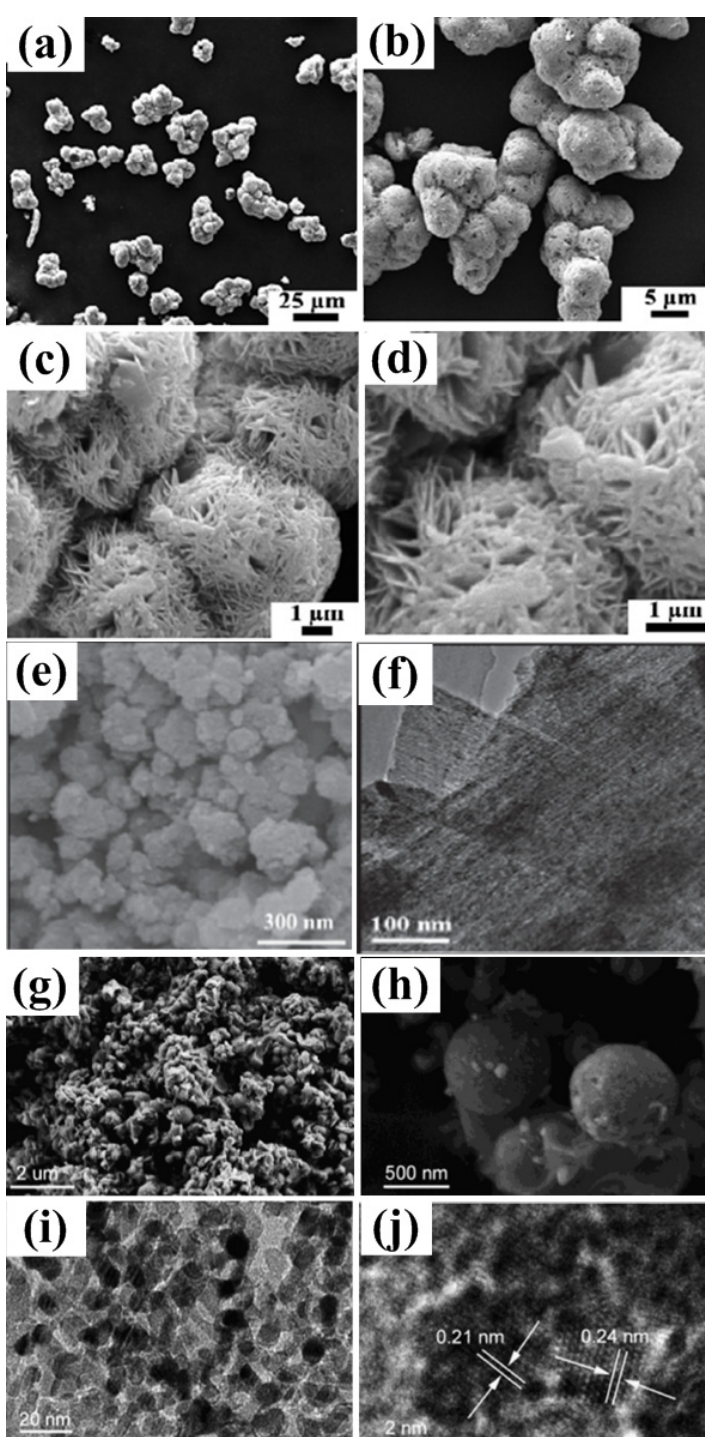
Figure 5. SEM images of the synthesized NiO microspheres (obtained by thermal decomposition of the Ni(OH) 2 precursor after refluxing treatment for 60 min) at different magnifications ( a – d ) [43]. ( e ) SEM and ( f ) high resolution transmission electron microscopy (HRTEM) images of the NiO sample synthesized via a hydrothermal route with sodium dodecyl benzene sulfonate (SDBS) as an additive [46]. SEM images ( g , h ) at different magnifications, and TEM ( i ) and HRTEM ( j ) images of NiO sample prepared by using porous carbon nanospheres as a hard template